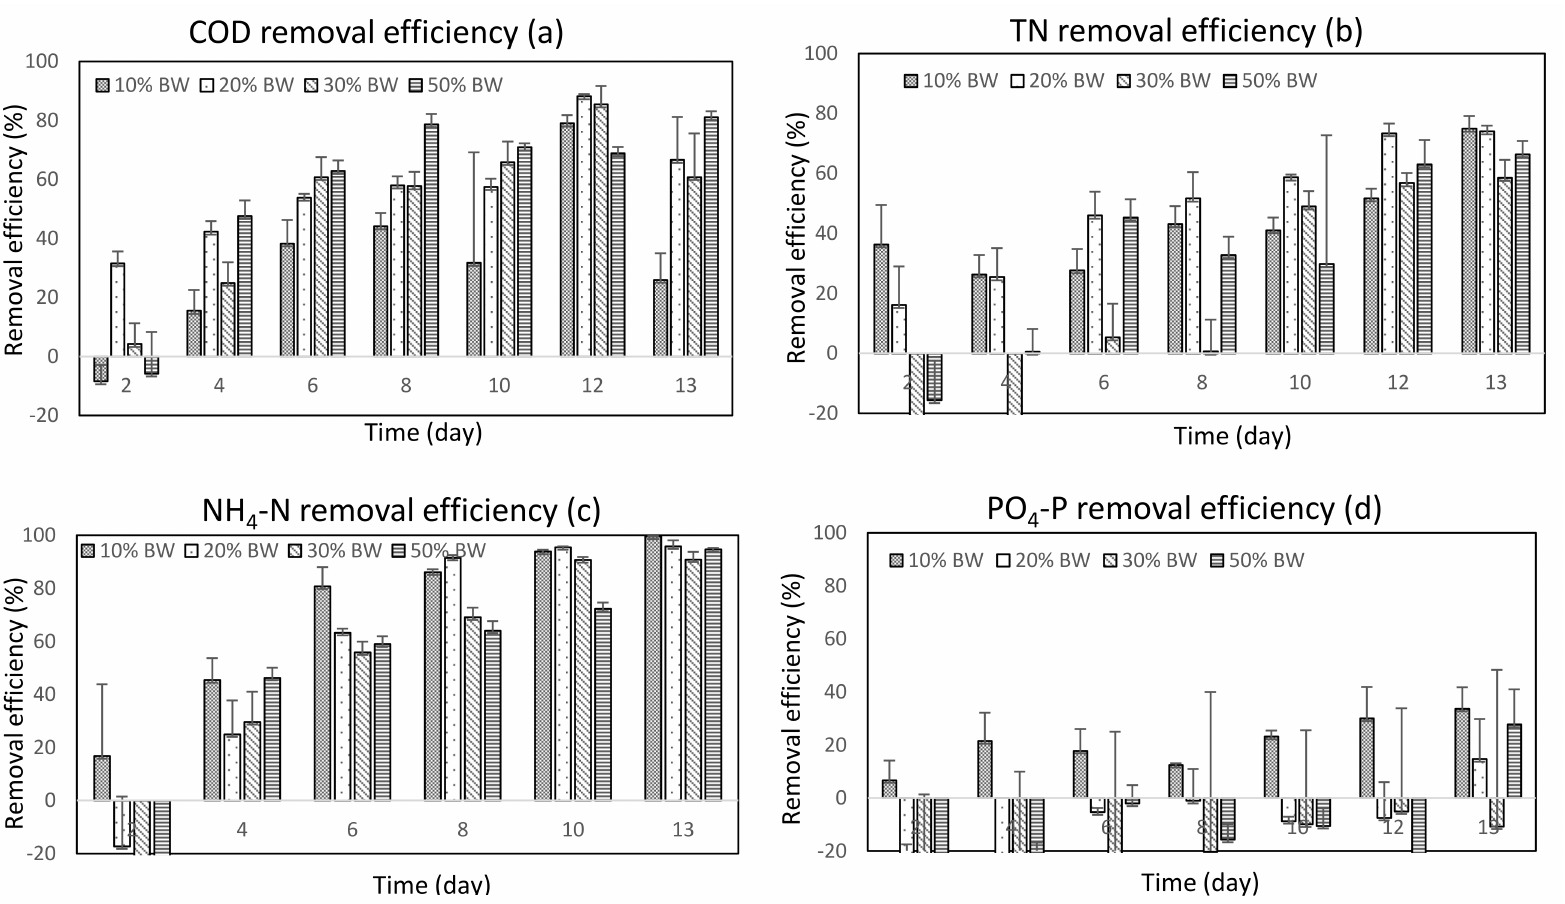
Figure 3. Removal e ffi ciencies of chemical oxygen demand (COD) ( a ), total nitrogen (TN) ( b ), ammonium-nitrogen (NH 4 -N) ( c ), and orthophosphate (PO 4 -P) ( d ) in di ff erent dilutions of blackwater (BW) ( n =